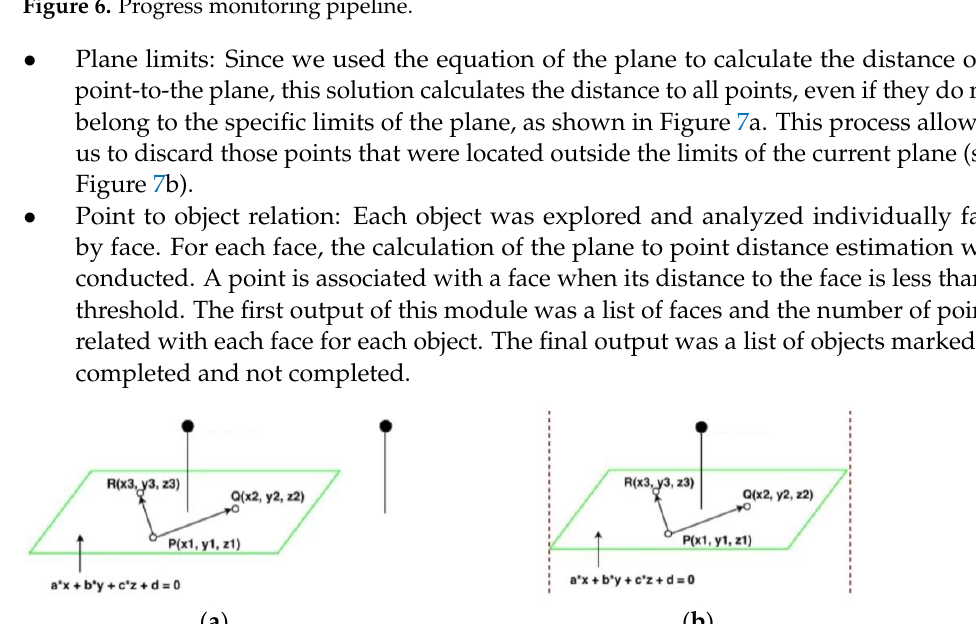
Figure 6. Progress monitoring pipeline.